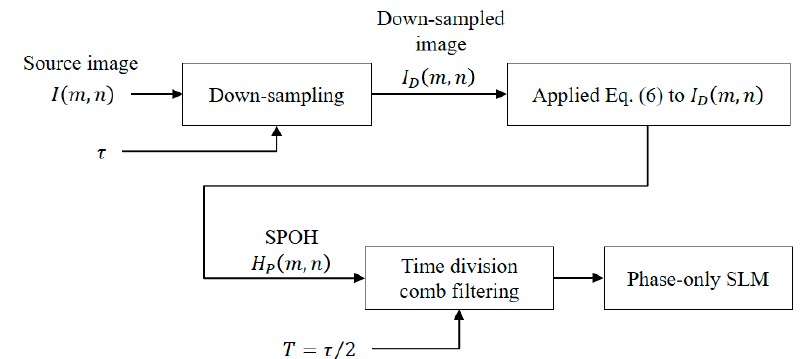
( c ) Figure 3. Frequency spectrum of signal 𝐼(cid:4666)𝑚(cid:4667) : ( a ) without down-sampling, ( b ) after down-sampled by 2 times, ( c ) after down-sampled by 4 times. The above analysis can be directly applied to down-sampling of a 2-D image 𝐼(cid:4666)𝑚, 𝑛(cid:4667) along the horizontal, and vertical directions. From Figure 3, it can be seen that the sparsity of a down-sampled signal can be decreased by reducing the number of replicas spectrum, which is equivalent to lowering